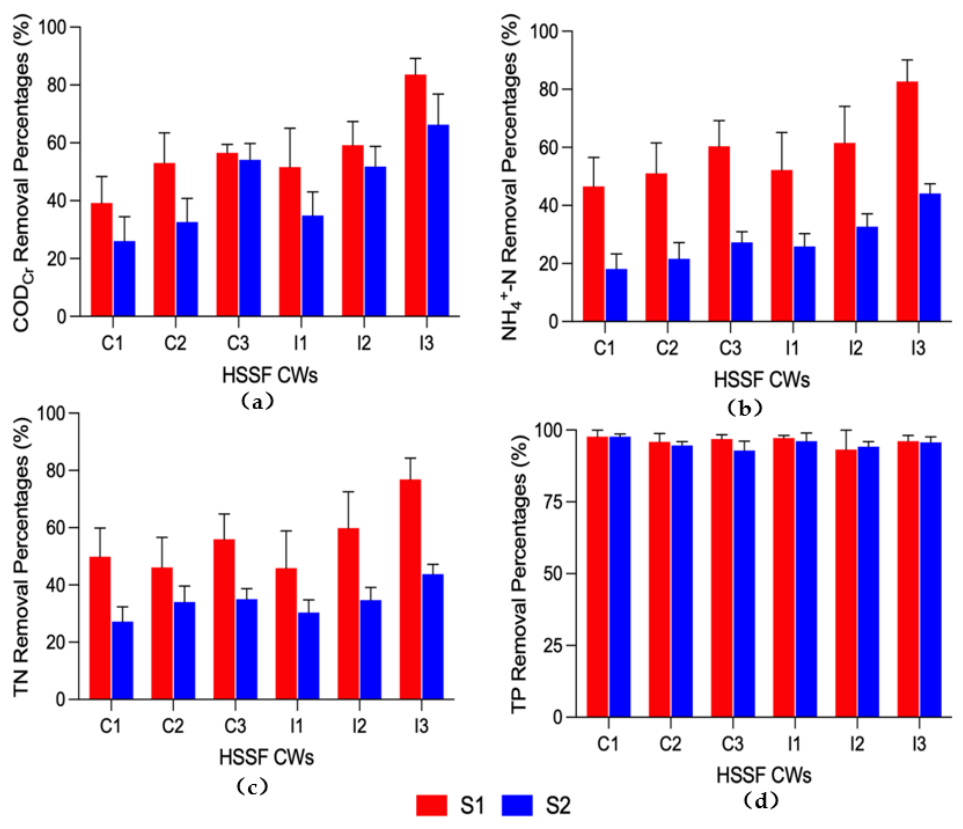
Figure 4. Total removal efficiencies of COD Cr , NH 4+ -N, TN and TP by HSSF-CW plots. ( a ) COD Cr ; ( b ) NH 4+ -N; ( c ) TN; ( d ) TP. Vertical thin bars represent standard deviations ( n = 5). The experiment was divided into two stages: S1 (T ≥ 15 °C) and S2 (T < 15 °C)